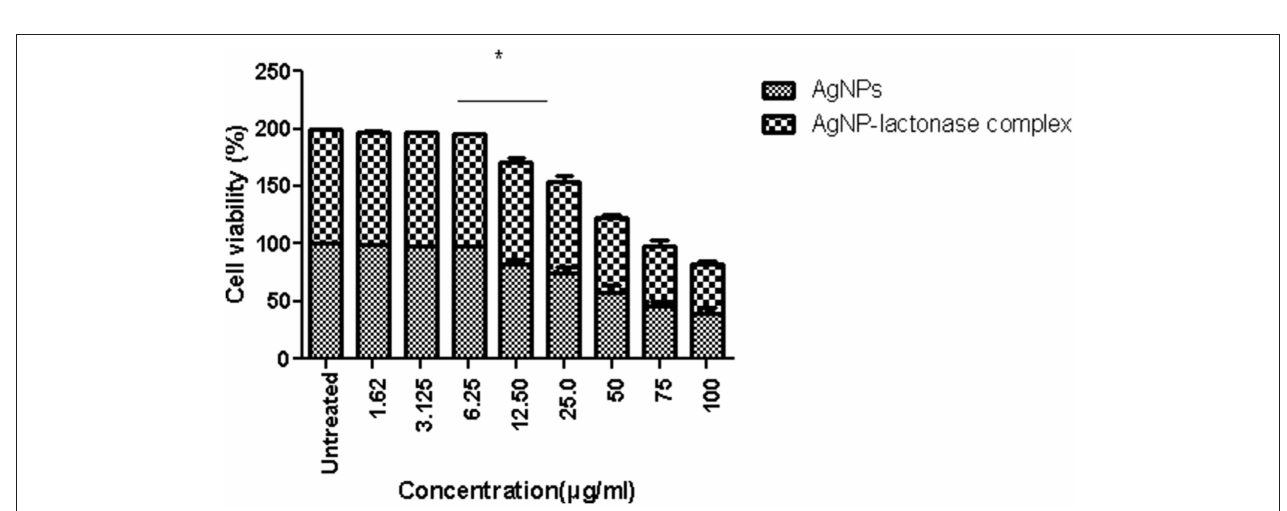
FIGURE 12 | Intracellular ROS generation in K. pneumoniae upon time dependent exposure to neat AgNPs and AgNP- AiiA complex. P -value < 0.001 (highly significant) (vs. control) was observed for every value of ROS generation.